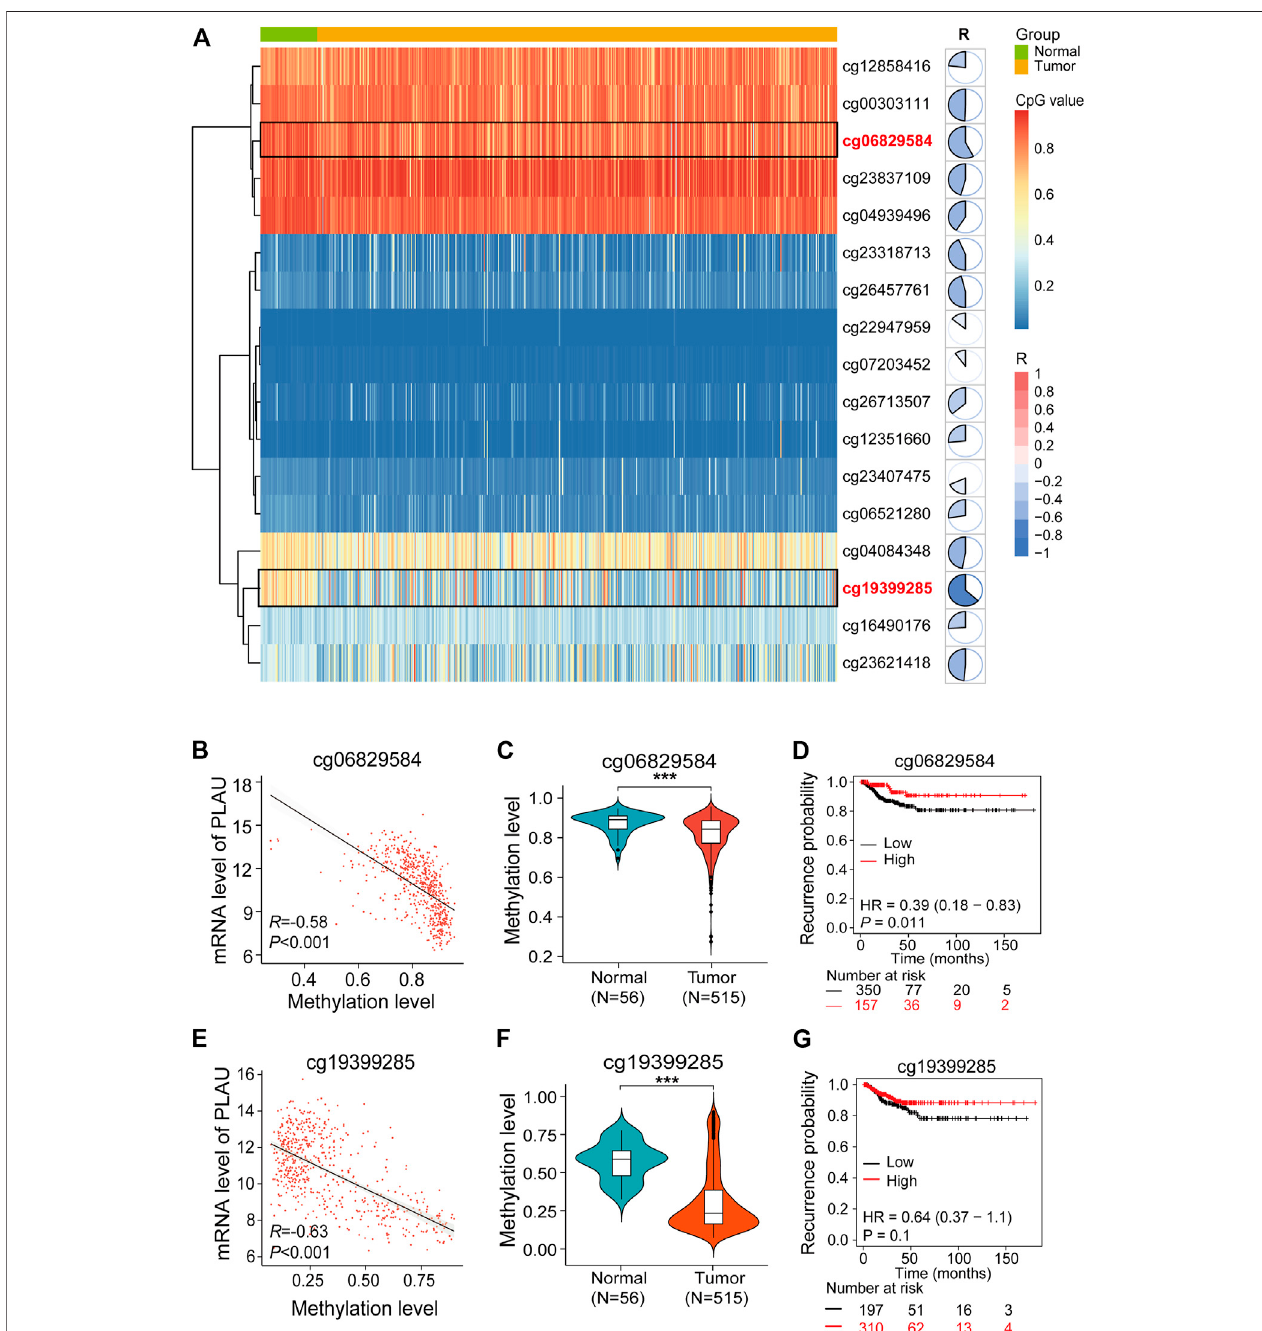
FIGURE 7 | Aberrant methylation of cg06829584 results in the upregulation of PLAU in THCA. (A) Heatmap showing the expression of different probes in THCA. Pie charts show the correlation between the expression of probes and PLAU. (B,E) Pearson correlation was applied to analyze the correlation between the mRNA level of PLAU and the methylation level of the cg06829584 and cg19399285 probes. Violin plots showing the methylation levels of the cg06829584 (C) and cg19399285 probes (F) betweennormalandtumortissuesinTHCApatients,Student ’ st-test,*** p < 0.001.Kaplan-Meierplotoftherelapse-freesurvival(RFS)inTHCApatients with different methylation levels of the cg06829584 (D) and cg19399285 probes (G) .